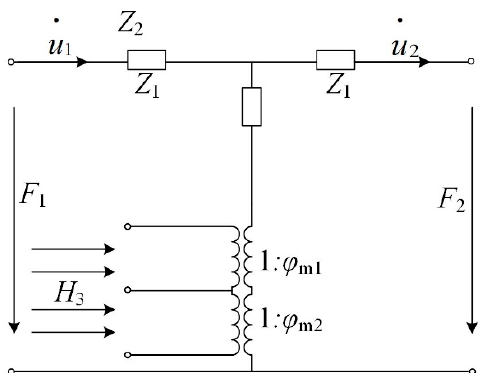
Figure 2. Magneto ‐ elastic equivalent circuit of the magnetization ‐ graded ferromagnetic materials Figure 2. Magneto-elastic equivalent circuit of the magnetization-graded ferromagnetic materials (MGFM).